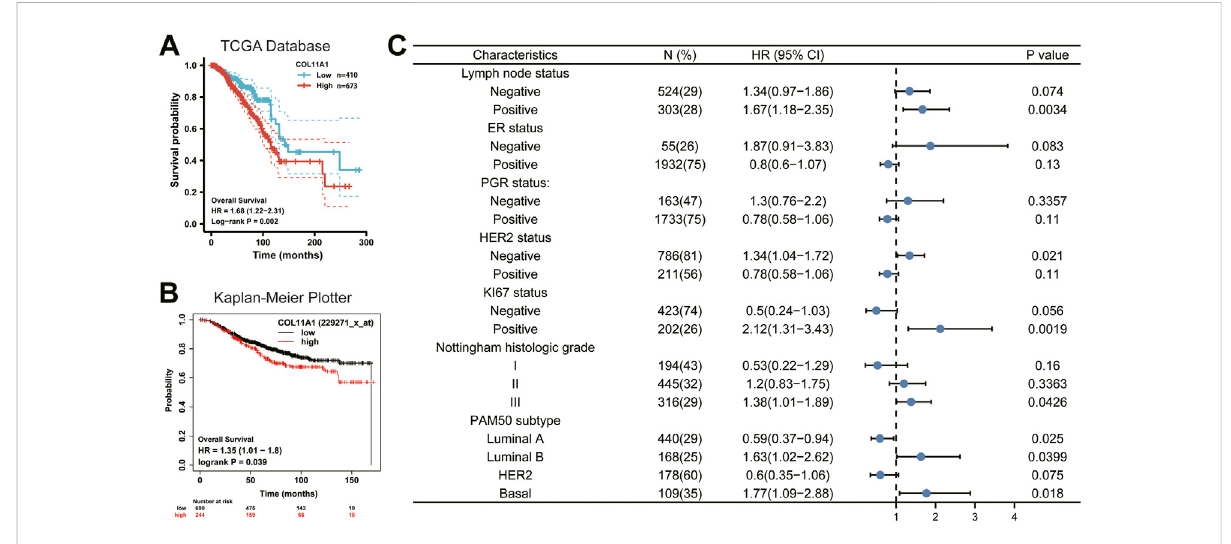
FIGURE 3 Survival curve evaluating the prognostic value of COL11A1. (A) Survival curve using the TCGA database is shown for OS. (B) Survival curve using theKaplan-MeierplotterisshownforOS. (C) AforestplotshowsthecorrelationbetweenCOL11A1expressionandclinicopathologicalparametersin BRCA